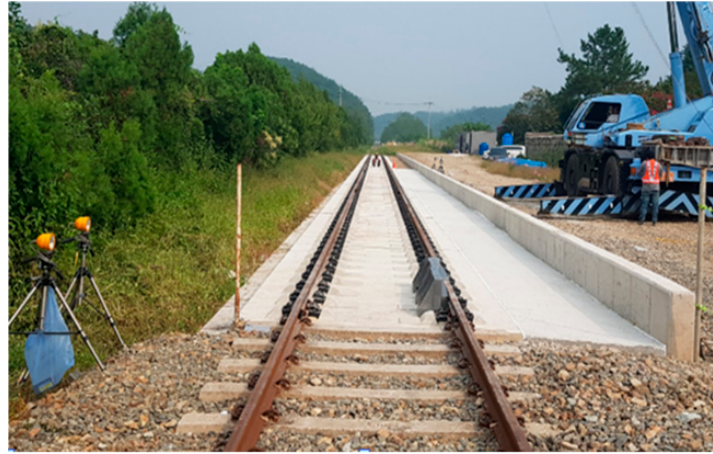
Figure 9. The derailment testing ground.